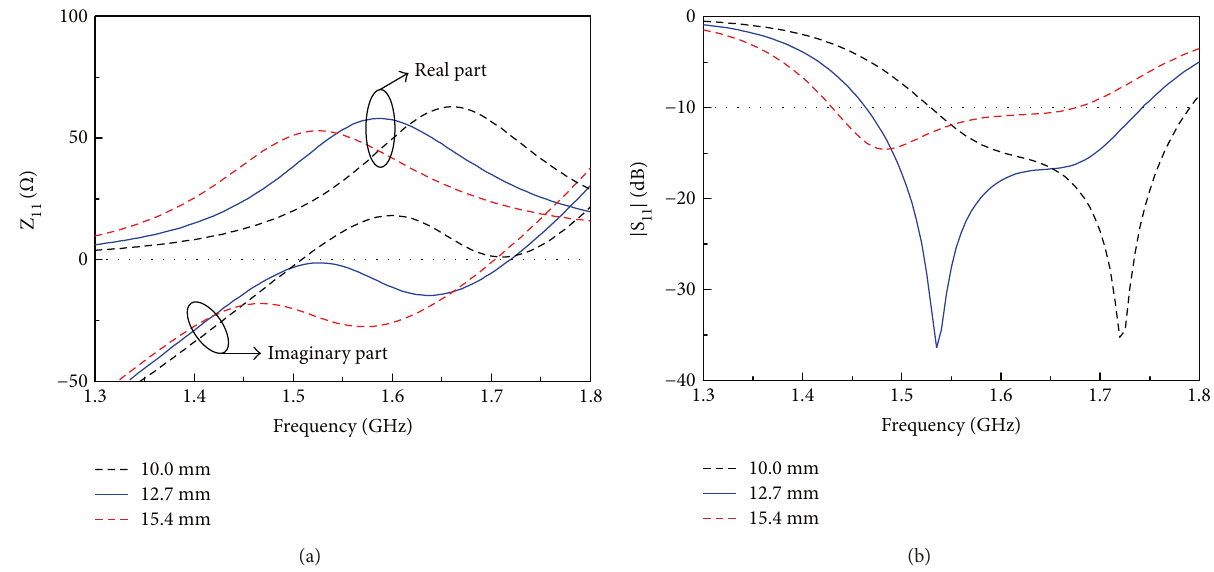
Figure 7: Simulated (a) input impedance and (b) |S from the ground plane to the parasitic patches ( H